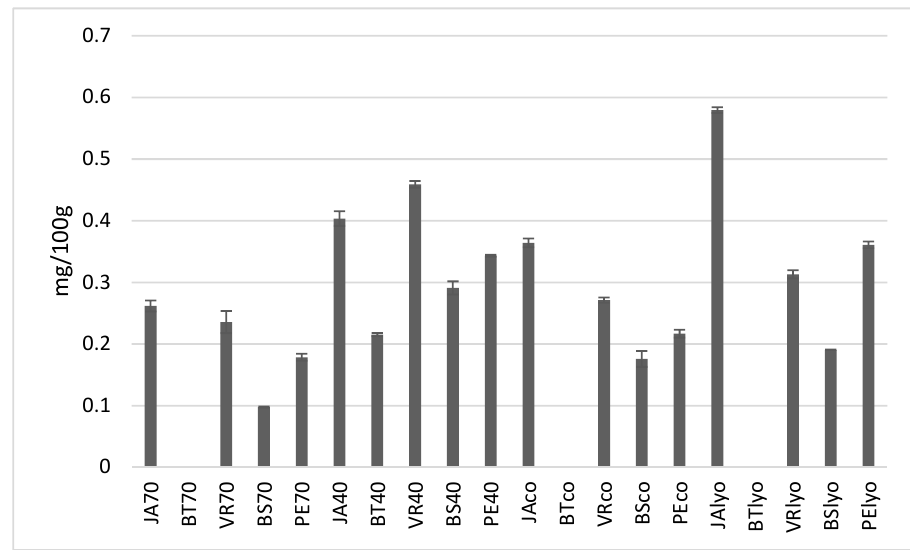
Figure 1. Concentration of vitamin C in individual varieties depending on drying method (70 °C, 40 °C, combined, lyophilised) in mg/100 g. Varieties: JA—Jakubské, BT—Beauty seedless, PE—Perlette, VR—Vrboska, BS—Bezsemenné.